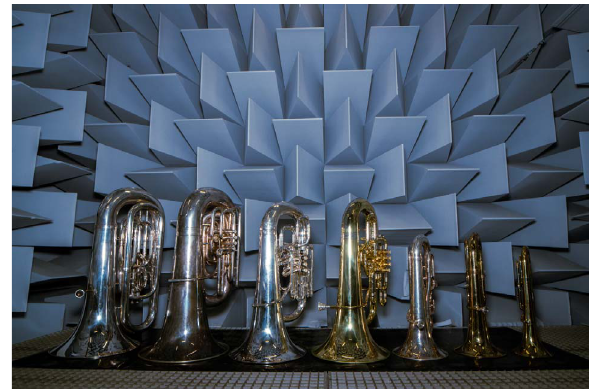
Figure 1. Photograph showing the different tubas studied in the present publication. From left to right (lowest to highest nominal pitch): contrabass tuba in B [ , contrabass tuba in C, bass tuba in E [ , bass tuba in F, euphonium in B [ , bass saxhorn in B [ , baritone saxhorn in B [ . Details about each tuba can be found in the Table